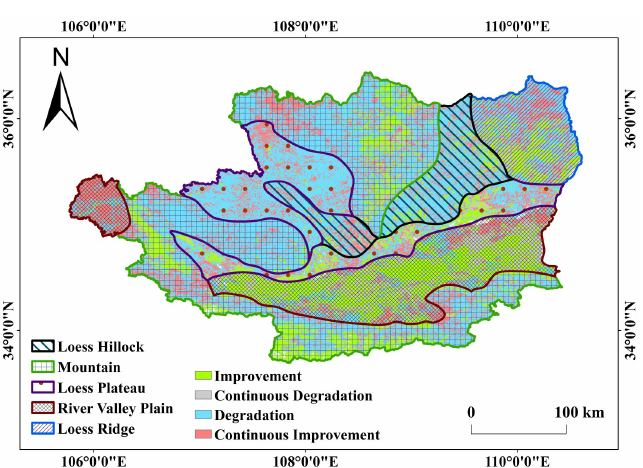
Figure 20. Future trend of EE.